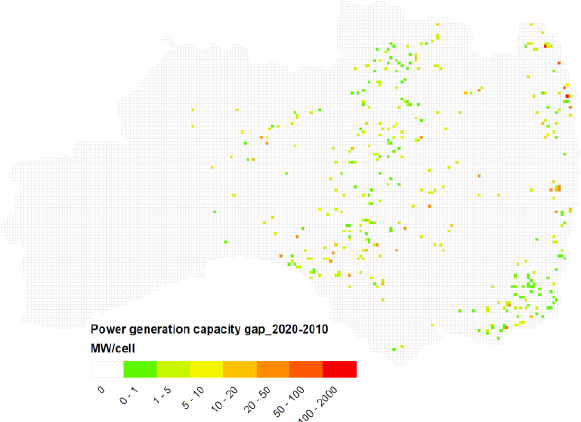
Figure 5. The map on the development of the